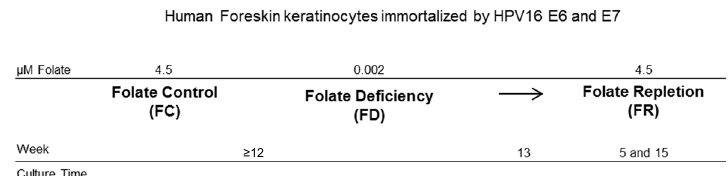
Figure 1. Schematic overview of the experimental cellular model and cultivation time course.